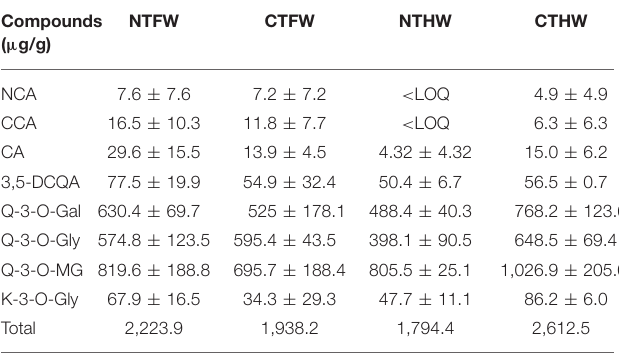
the specific analytes was performed considering three biological replicates (i.e., leaves coming from plants cultivated in different plots). NTFW, not-tilled and fully watered plots; CTFW, conventionally tilled and fully watered plots; NTHW, not-tilled and half-watered plots; CTHW, conventionally tilled and half-watered plots. < LOQ: values not quantifiable since below the limit of